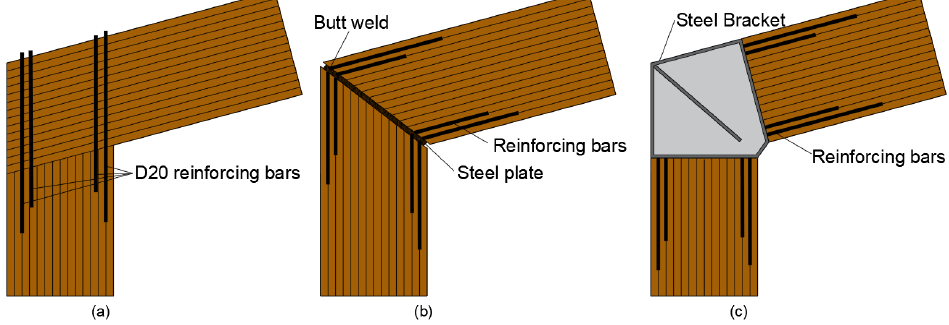
Figure 15. Moment-resisting glulam connections tested (adapted from Ref. [43]).